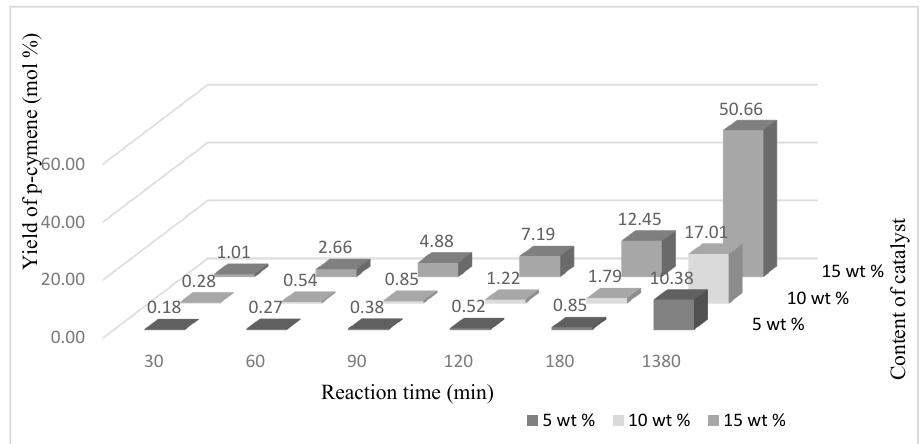
Figure 8. Influence of the amount of the catalyst and the reaction time on the yield of p-cymene, for the reaction carried out at 160 °C. The amount of the catalyst was 5, 10, or 15 wt %, and the reaction time was 30, 60, 90, 120, 180, or 1380 min.